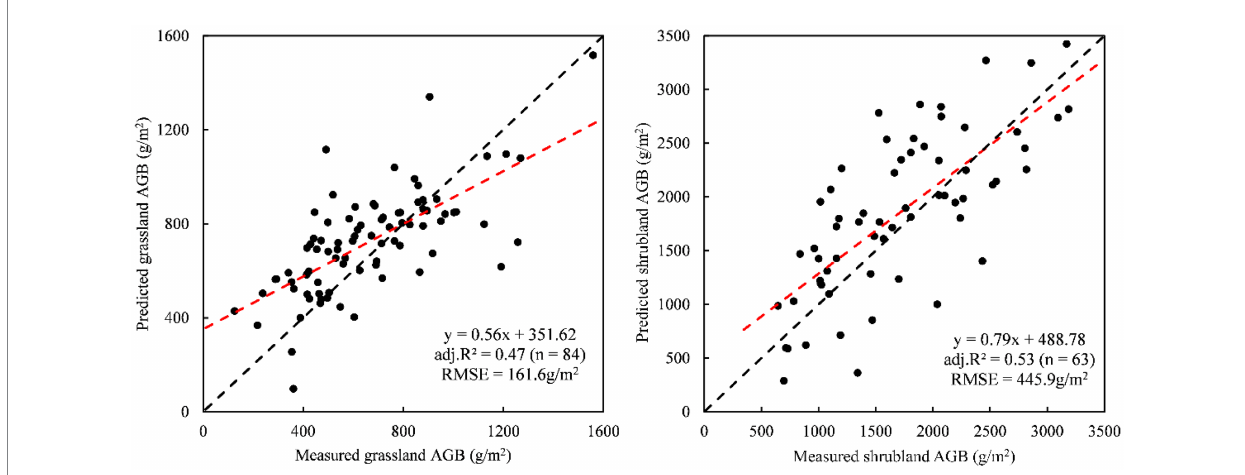
FIGURE 5 Scatter plot between measured and predicted AGB for grassland and shrubland using the RF based on the MODIS data with 250 m spatial resolution.